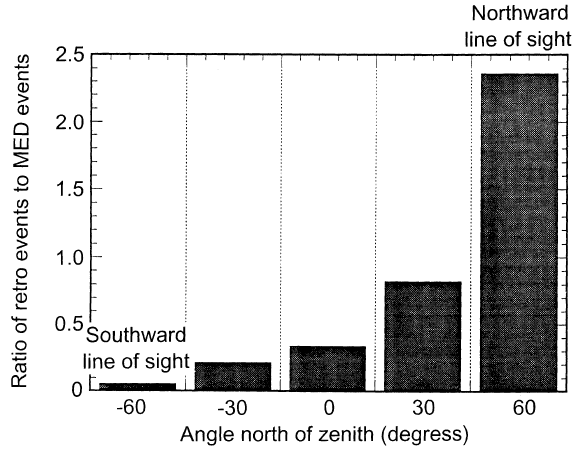
Fig. 15. ( Top ) Histogram showing that retrograde events are seen along lines of sight relatively insensitive to zonal motion (cf. Fig. 12). ( Bottom ) Histogram indicating that retrograde events are seen along lines of sight north of